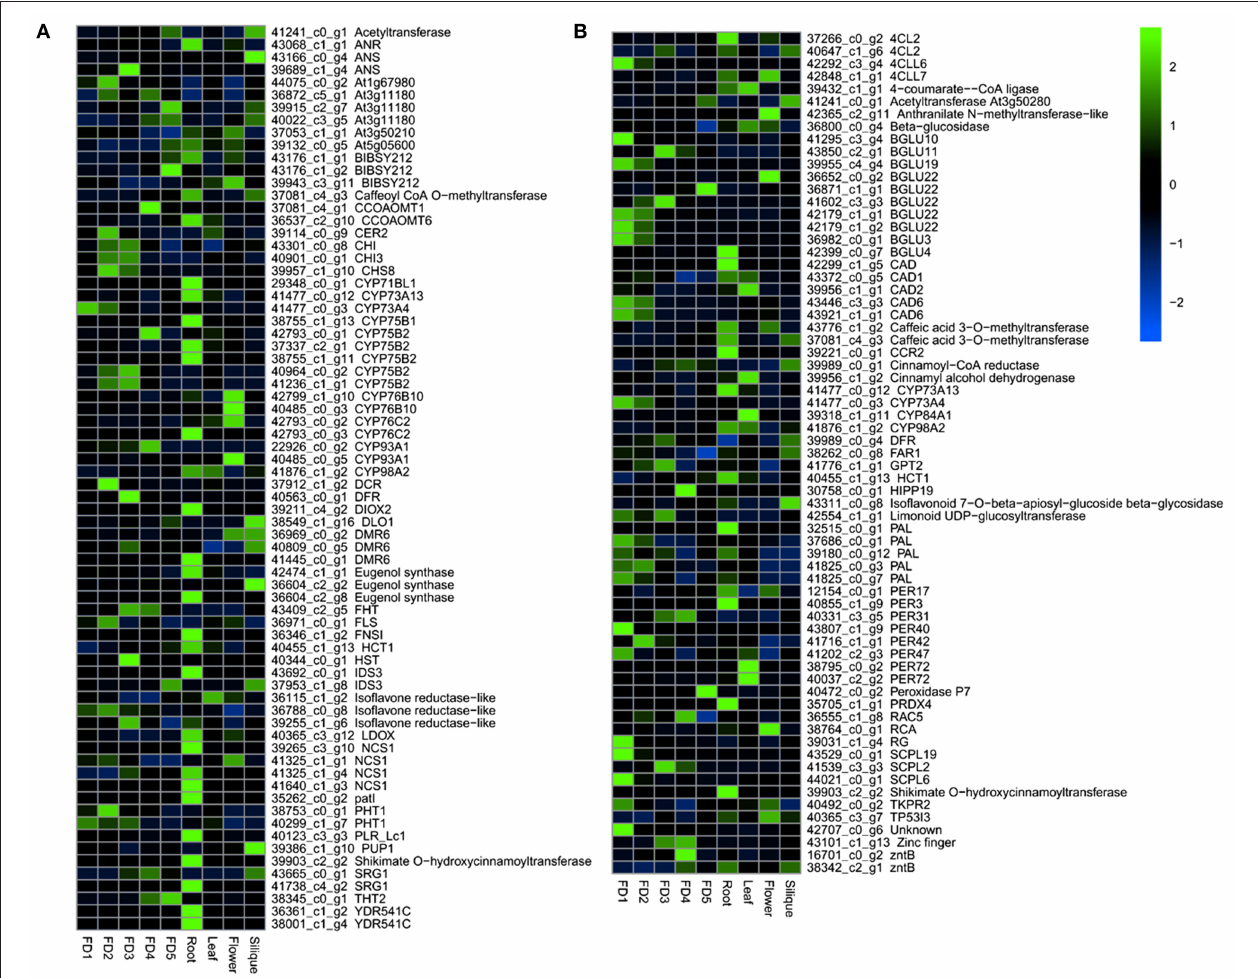
FIGURE 2 | The heatmap of major DEGs involved in the biosynthesis of flavonoids (A) and phenylpropanoids (B)